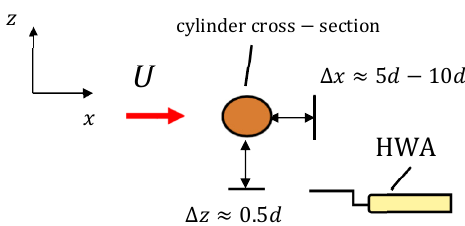
Figure 3. Schematic representation of the location of the hot-wire anemometer (HWA) relative to the cylinder during vortex shedding frequency measurements.